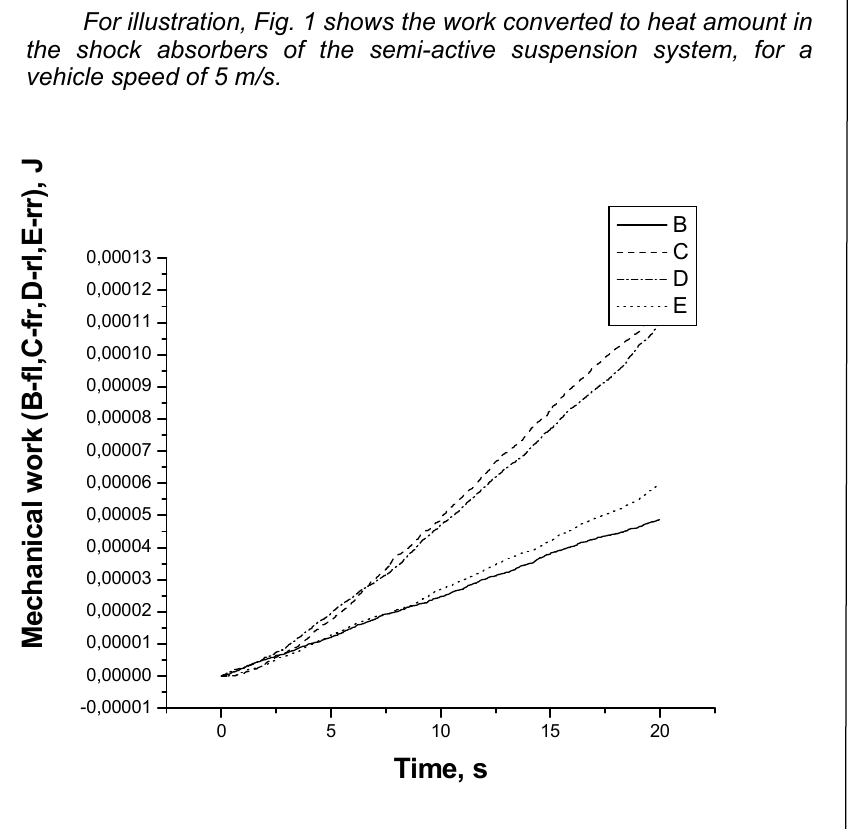
Figure 1 – Mechanical work (heat amount) in shock absorbers for a speed of vehicle